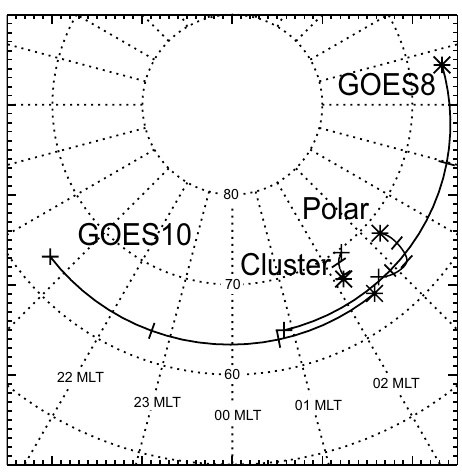
Fig. 3. MLT – invariant latitude (AACGM) locations of the mag- netic footprints of Cluster 1, Polar, GOES 8 and GOES 10 between 06:00 and 12:00UT calculated using the T89 model. The initial and final positions of the spacecraft are shown as crosses and aster- isks respectively. The spacecraft positions are marked by dashes at 2-hourly